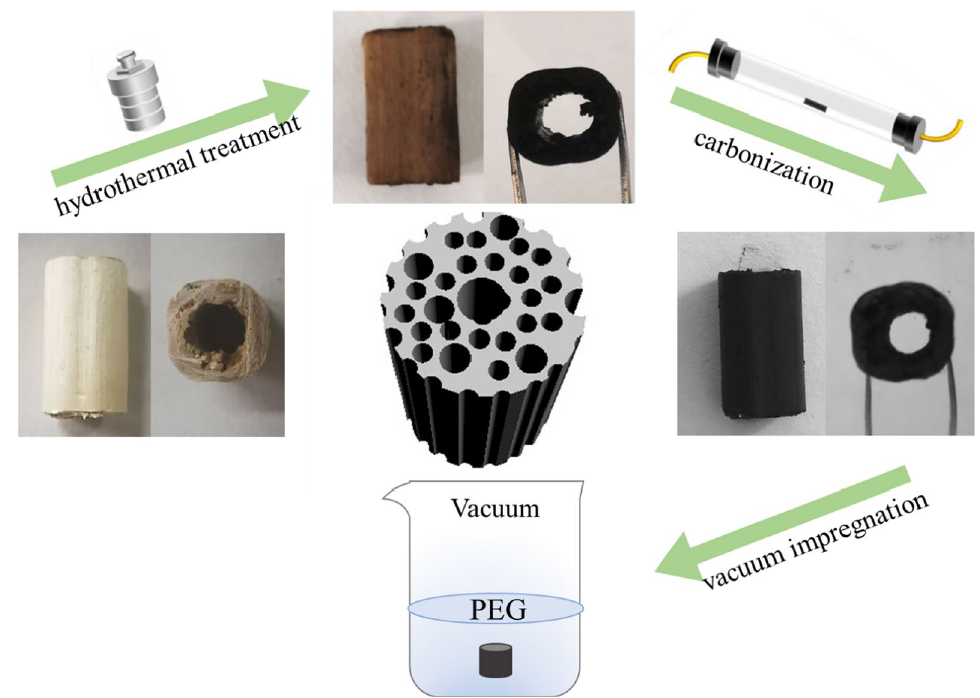
Fig. 1 The schematic diagram for preparation of CH/PEG